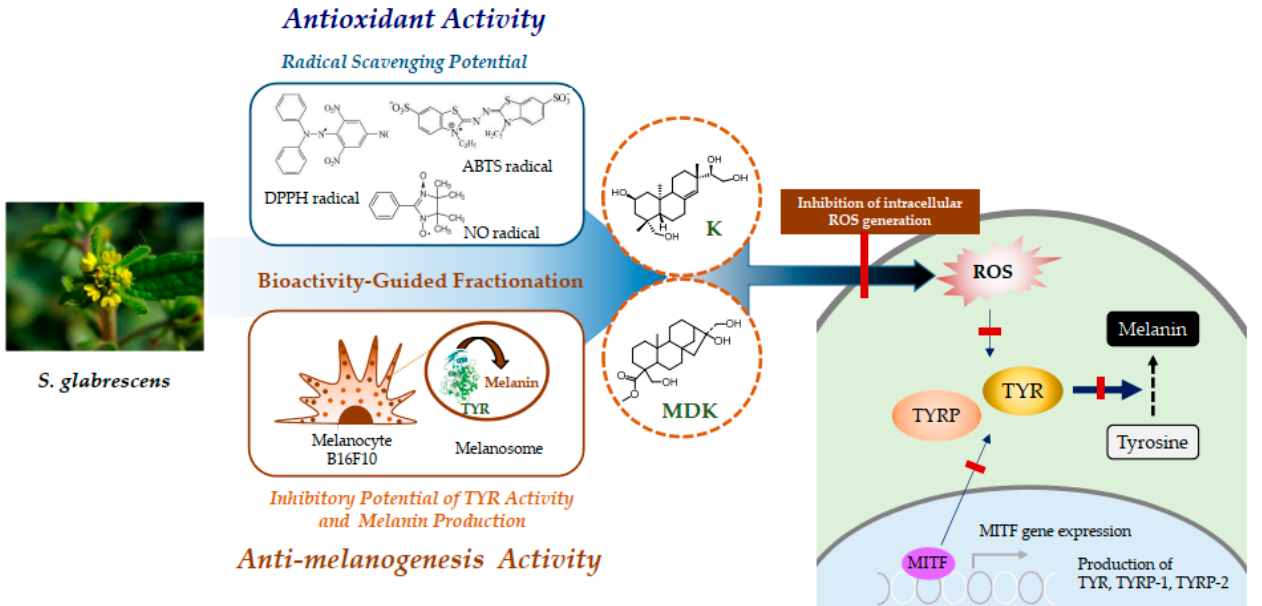
Figure 7. Summary on antimelanogenesis and antioxidant effects K and MDK isolated from S. glabrescens by bioactivity- guided fractionation.